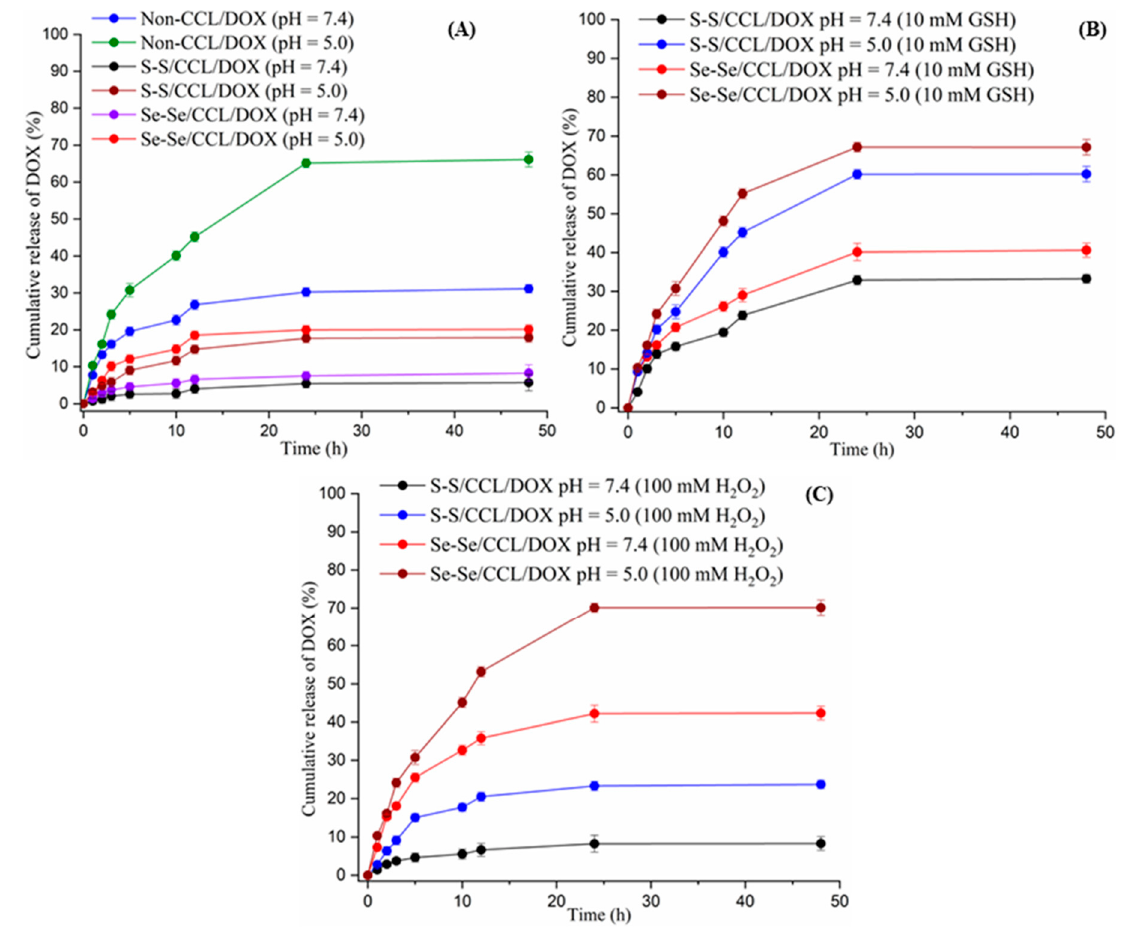
Figure 8. Cumulative release of DOX from non-CCL and CCL micelles at pH 5.0 and pH 7.4 ( A ), with GSH ( B ), and H 2 O 2 ( C ). Table 4. Release kinetic parameters of all formulations at pH 7.4 and 5.0.